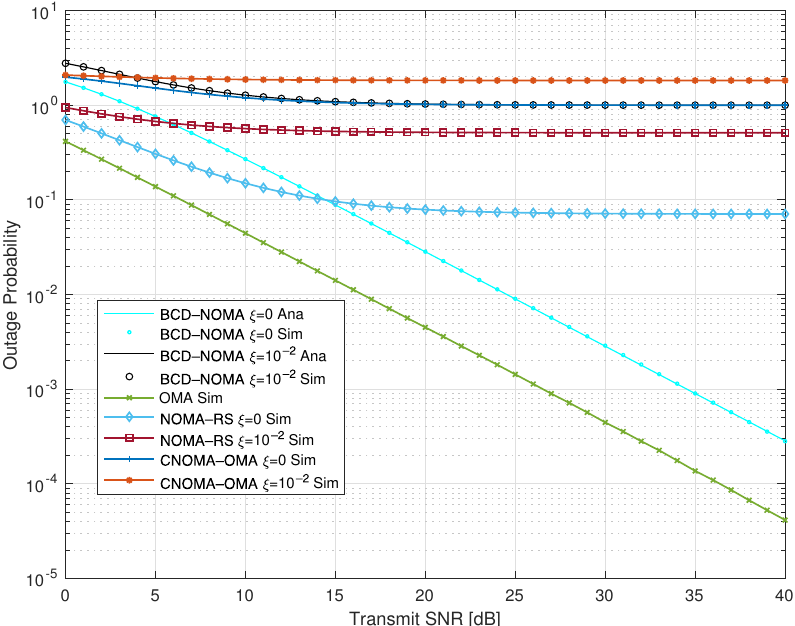
Figure 3. Outage probability comparison of BCD-NOMA scheme with